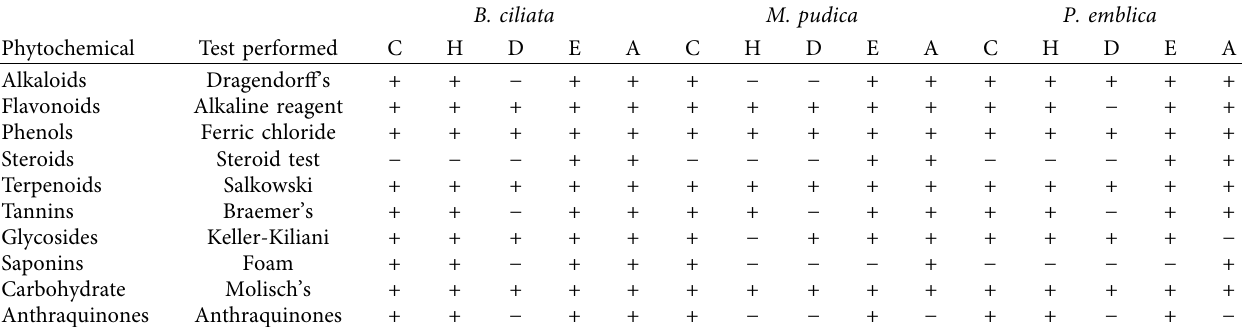
Table 2: Phytochemical identification of